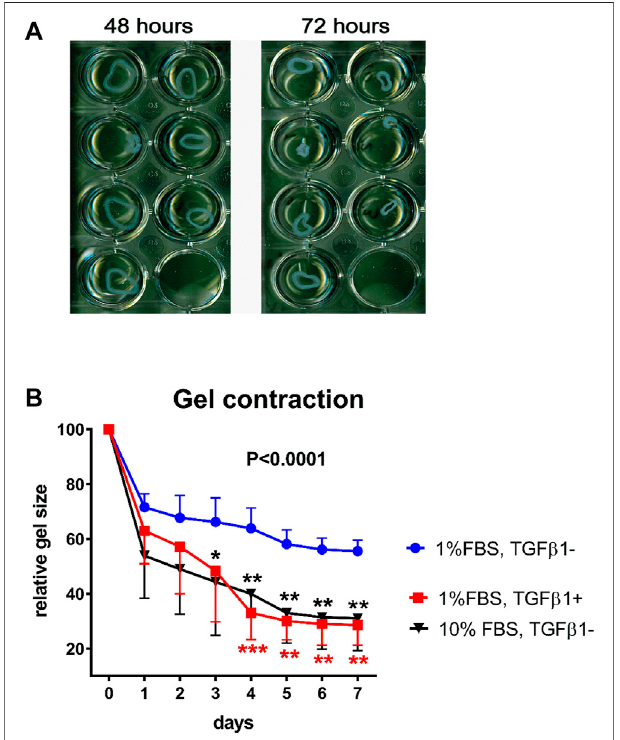
FIGURE 6 | Valve interstitial cells in 3D collagen cultures. Contraction of collagengel containingcultured interstitial cellsfrom calci fi ed aortic valves (n= 4) and treated with 1% FBS with or without TGF- β 1 over a period of 7 days. Panel (A) shows how the cultures contract and become smaller. Panel (B) shows the collective data of gel contraction of VIC from healthy aortic valves(n=4)understimulation withlow-serum (1%FBS) withorwithoutTGF- β 1 or with high-serum (10% FBS) without TGF- β 1. Gel sizes on day 0 were considered as 100%. Data were analyzed by two-way ANOVA with repeated measures. Differences between treatments with1% FBS withTGF- β 1 (shown in red stars) or 10% without TGF- β 1 (shown in black stars) compared to 1% FBS without TGF β 1 were determined with Sidak ’ s multiple comparison post- test, *indicates 0.01 < p ≤ 0.05, ** indicates 0.001 < p ≤ 0.01, *** indicates 0.0001 < p ≤ 0.001.Valuesareexpressedasmean±SD.Overall p -valuefrom two-way ANOVA is shown in bold.